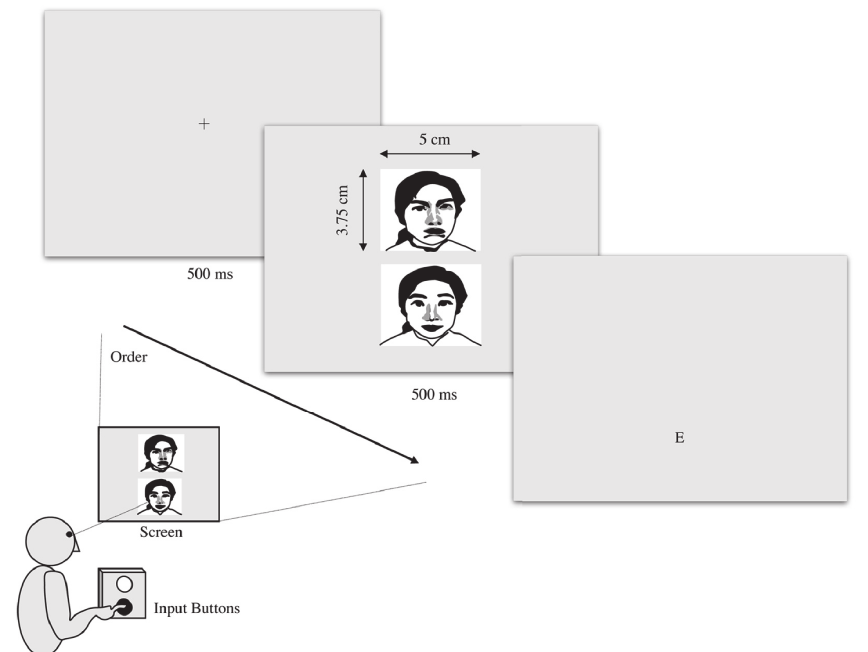
Fig 1. Procedure for measuring attentional bias. Once the facial photographs had been displayed for 500 ms, the subject was instructed to press a button to choose the most neutral face. The images were presented simultaneously, one above the other, at 1,600 (vertical) × 900 pixels (horizontal). The buttons could only be pressed after the images had been displayed, and the time taken to select the neutral image was recorded. Trials were performed 128 times, and RTs of < 200 or > 2,000 ms were excluded from the statistical analysis as